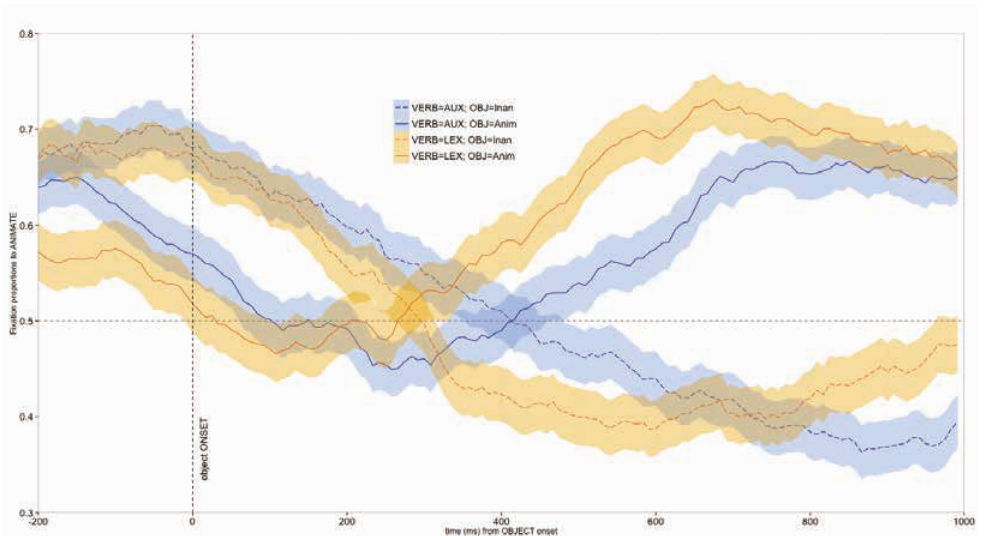
Figure 7: Gaze plot of animate fixation proportions in each condition time-locked to object onset. The lines indicate mean fixation proportions and the transparent bands indicate 1 SE above/below the means. Blue lines indicate conditions with an auxiliary finite verb, orange lines indicate conditions with a lexical finite verb, dashed lines indicate conditions with an inani- mate object, and straight lines indicate conditions with an animate object.